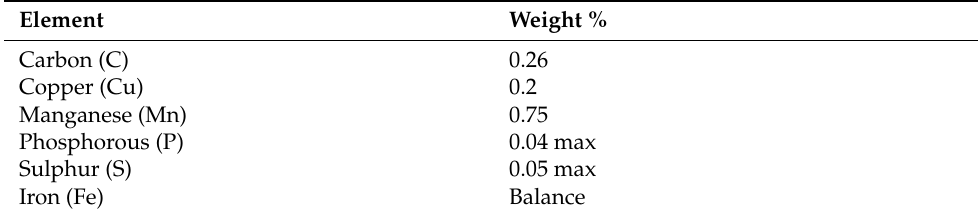
Table A1. Composition of Hot rolled Low Carbon Steel (AISI A36).